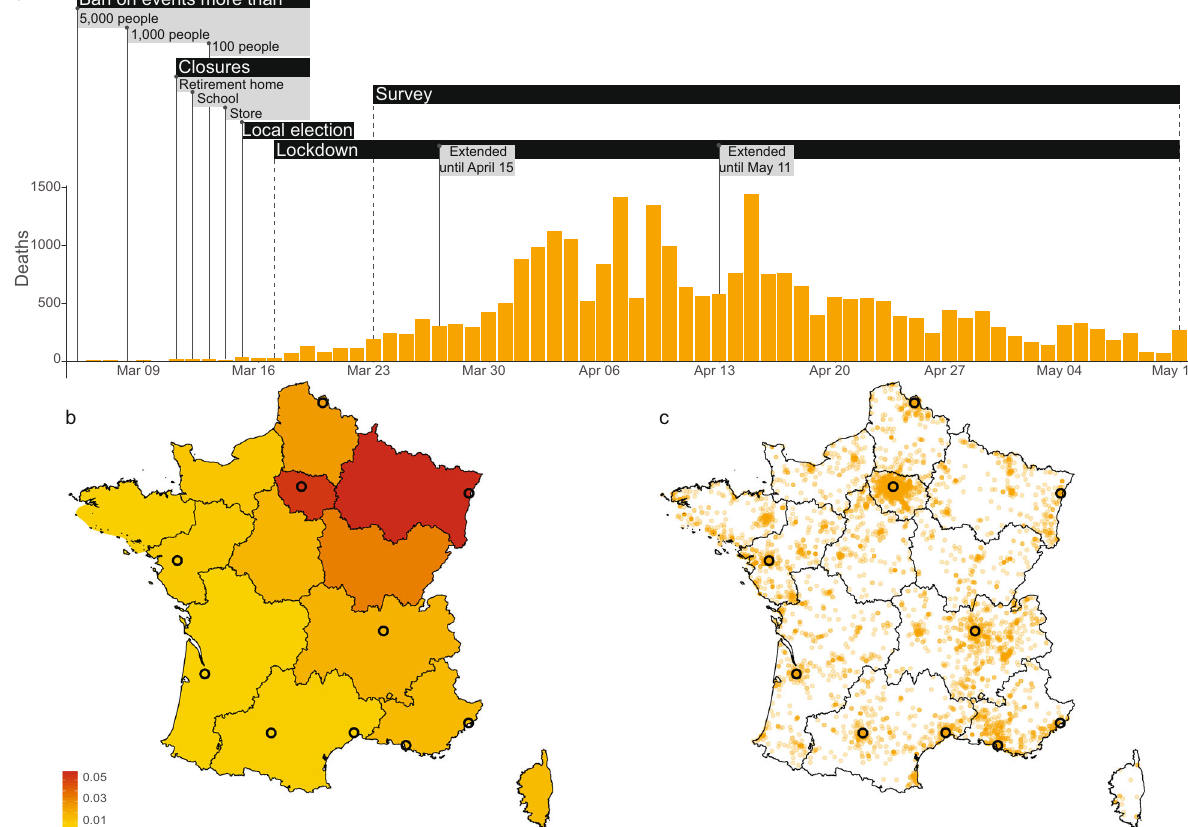
Fig. 1 French context of the Covid-19 until the last lockdown day. Part a reports the key dates (top panel) and the of fi cially reported daily deaths due to the Covid-19 (bottom panel). Part b represents the percentage of the regional population who died due to the Covid-19. Part c represents the residency position for all our